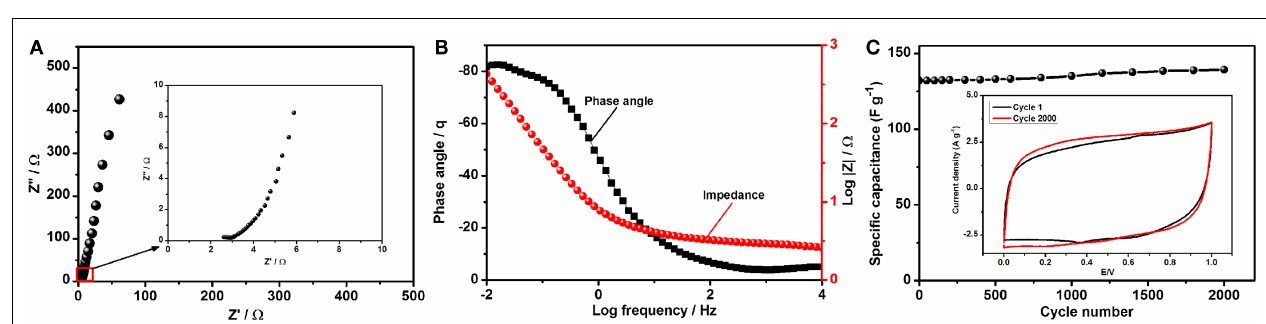
FIGURE 8 | Electrochemical behavior of the assembled asymmetric supercapacitor device: (A) Nyquist plot of the asymmetric supercapacitor, with the inset showing an enlargement of the indicated region; (B) Bode plot suggesting maximum phase angle; and (C) cycle life of the assembled asymmetric super capacitor over 2000 cycles at 50mVs − 1 , with the inset showing CV curves for cycles 1 and 2000